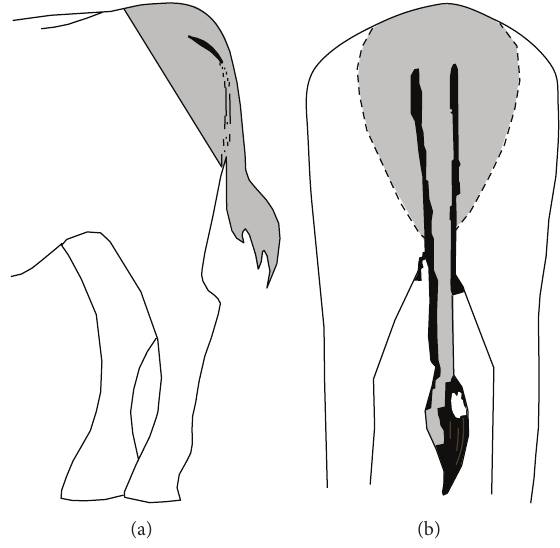
Figure1:Schematicdiagramfromtheleftlateralview(a)andcaudal view (b) of a buffalo calf showing the area was tested by a pin-prick test (applied at the perineal region, tail base, and upper hind limb